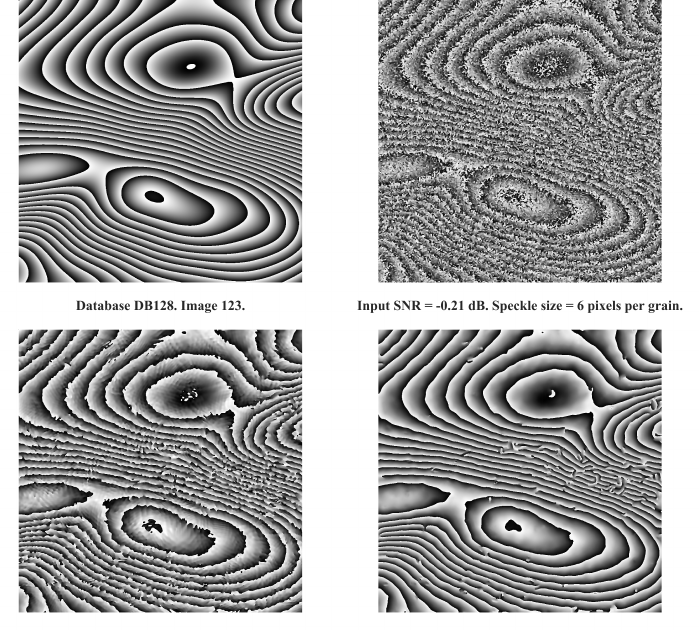
Figure 6. Comparison between WFT2F and DL_DB128_2 on image 123 of DB128-test database. From left to right and top to bottom : Noise-free phase, noisy input phase, de-noised phase with WFT2F and DL_DB128_2. Cosine input SNR is of 1.78dB. Phase error with WFT2F is equal to 0.52 rad. Phase error with DL_DB128_2 is 0.39